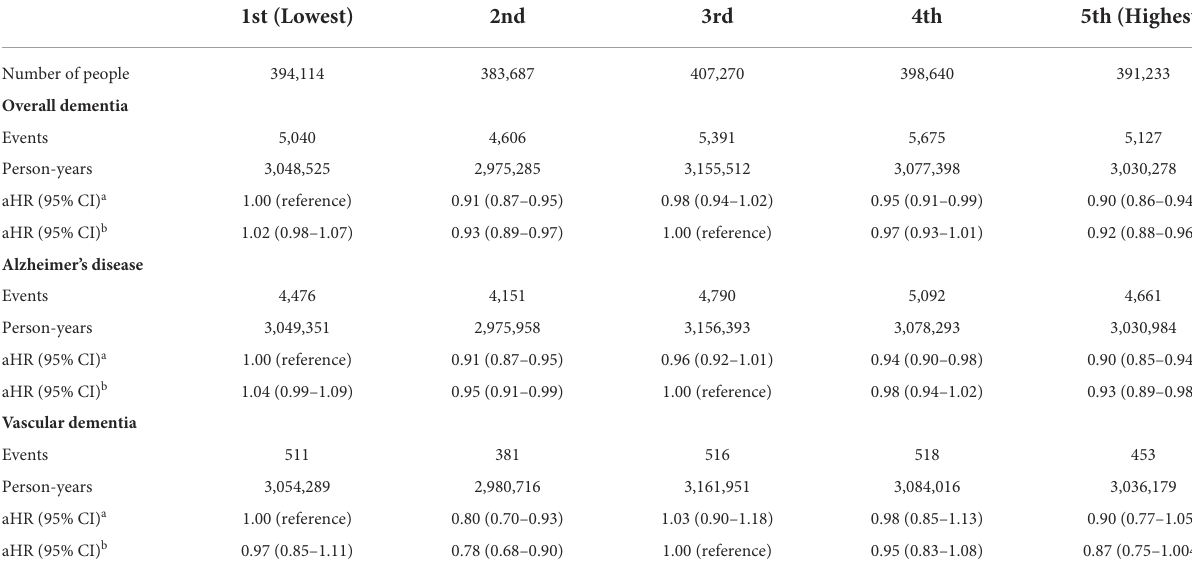
TABLE 2 Hazard ratios for dementia according to social